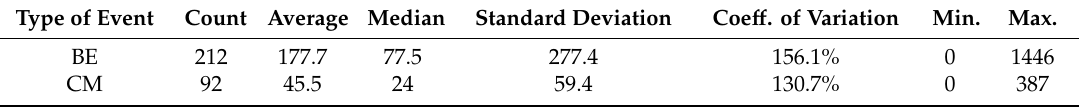
Table 3. Basic descriptive statistics for the number of meetings, depending on the type of promotional event.